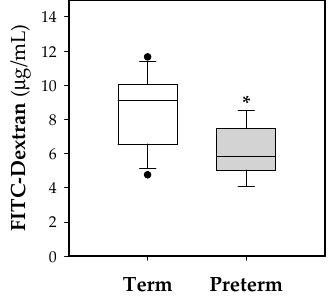
Figure 5. Box plot of intestinal permeability to 4 kDa-FITC-dextran in both experimental groups. Line indicates the median, box shows the interquartile range (IQR) and the whiskers are 1.5 × IQR ( n = 10 pups per group). Statistical differences: * p < 0.05 vs. term group.